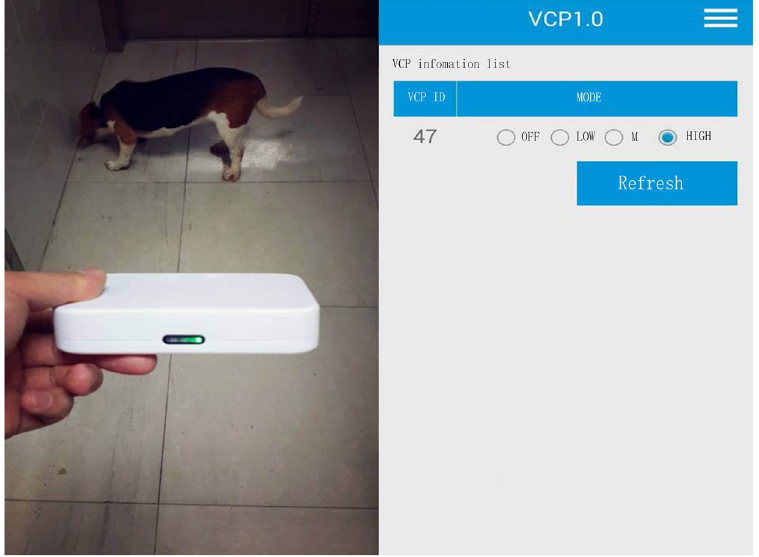
Figure 4. Activity of capsules can be detected and adjusted by configurator and configurator-matched App